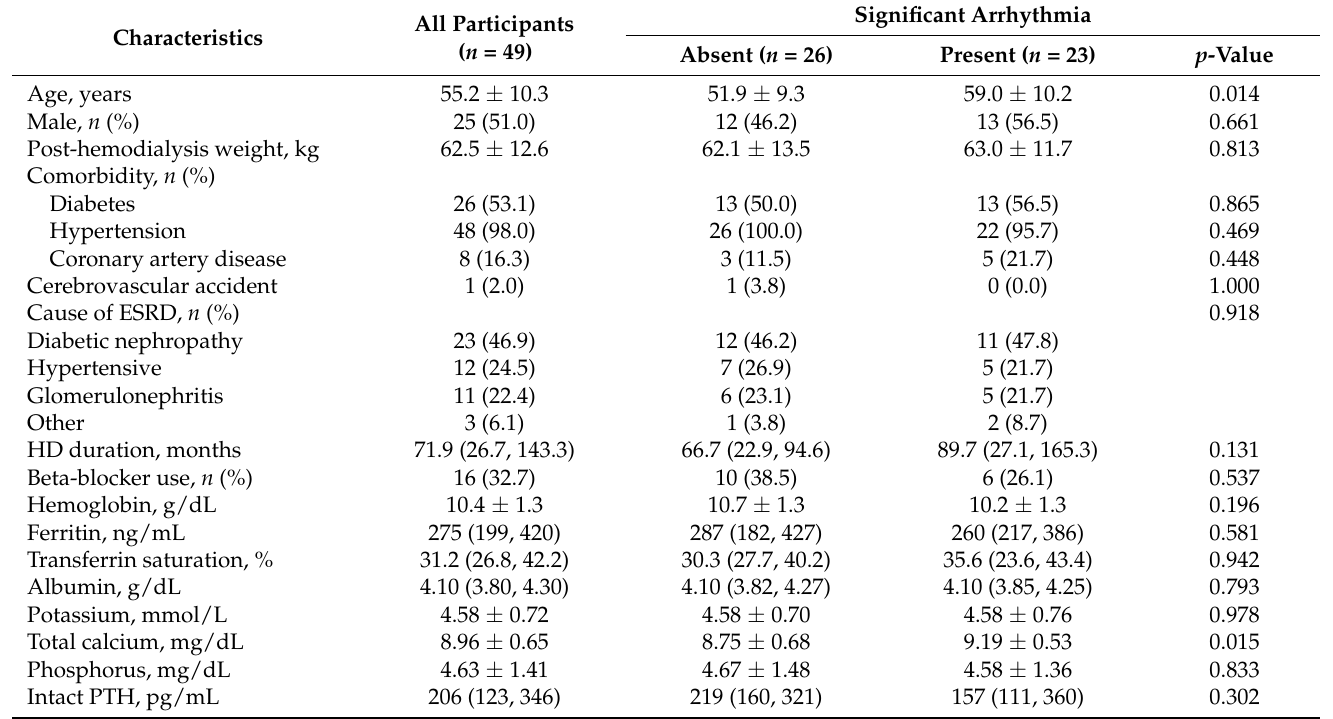
Table 1. Baseline characteristics of the